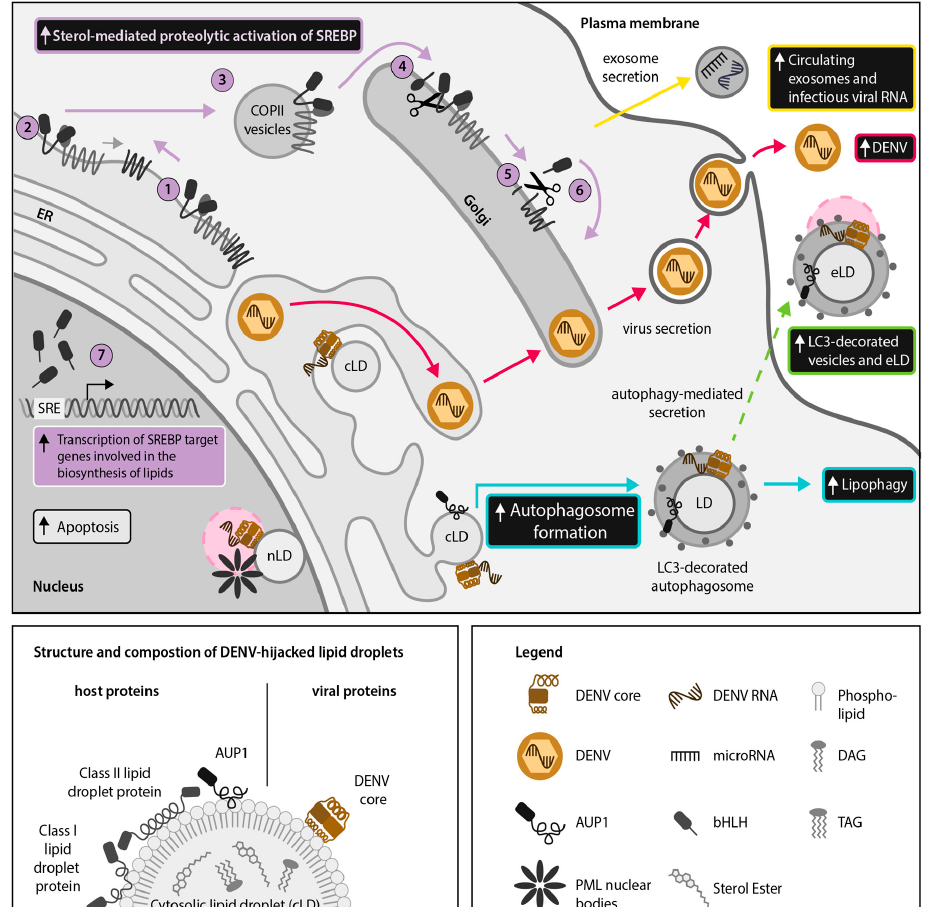
Figure 3. Dengue virus (DENV) dysregulates host lipid metabolism. DENV perturbs host lipid homeostasis by enhancing sterol regulatory element-binding protein (SREBP) activation (purple arrows: ( 1 – 7 )), leading to increased lipid droplet (LD) formation. DENV stimulates LD degradation via lipophagy by enhancing (ancient ubiquitous protein 1) AUP1 translocation from cytoplasmic LDs (cLDs) to microtubule-associated protein light chain 3 (LC3)-decorated autophagosomes (cyan arrows). Enhanced LD catabolism provides free fatty acids to serve as an energy source for production of infectious virions (red arrows). A recent report has shown that infectious viral RNA and extracellular LDs (eLDs) are contained within LC3-decorated extracellular vesicles in DENV-infected cells, suggesting that eLDs could be used as anchors for viral proteins. We hypothesize that the cLD-associated DENV core protein may also co-localize with eLDs in order to facilitate extracellular dissemination of viral RNA (green arrows). In addition, we propose that the DENV core protein may utilize nLDs as a sca ff old for interacting with promyelocytic leukemia (PML) nuclear bodies (pink circle), thereby promoting host cell apoptosis and suppressing host interferon responses. Hypothetical pathways are highlighted with dotted